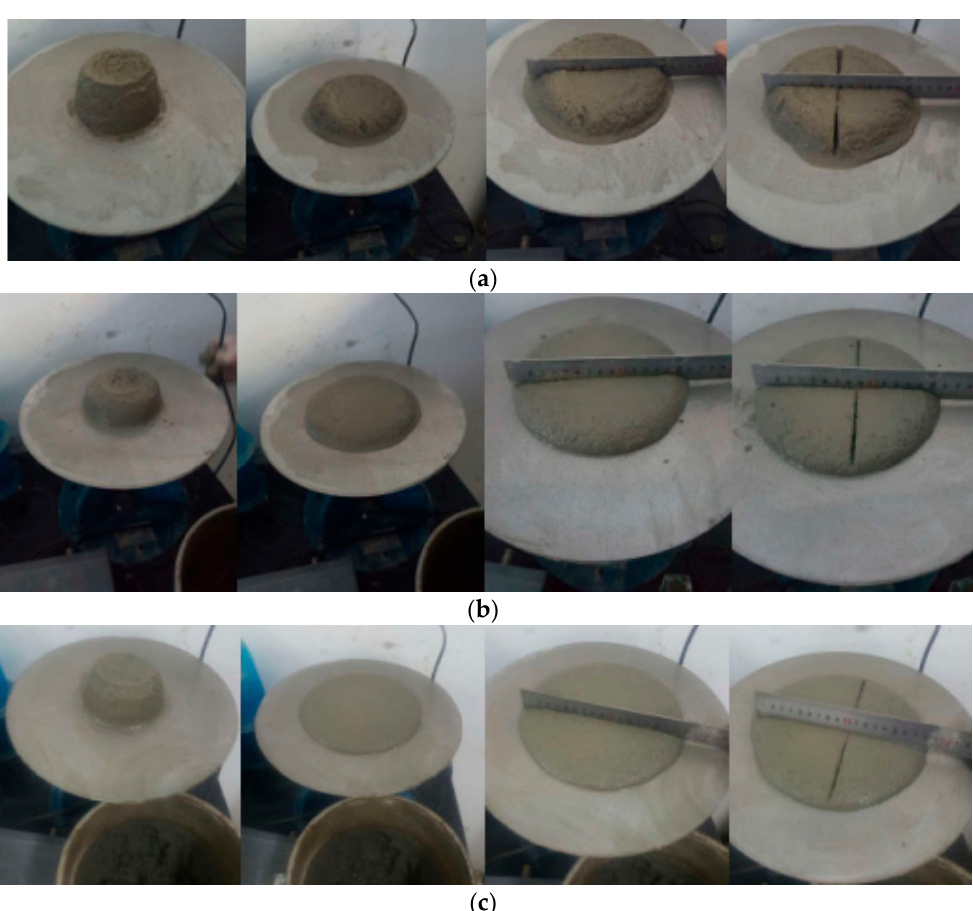
Figure 2. Slump flow of mortars ( a ) F 1 0, ( b ) Q30 and ( c ) F 1 30.